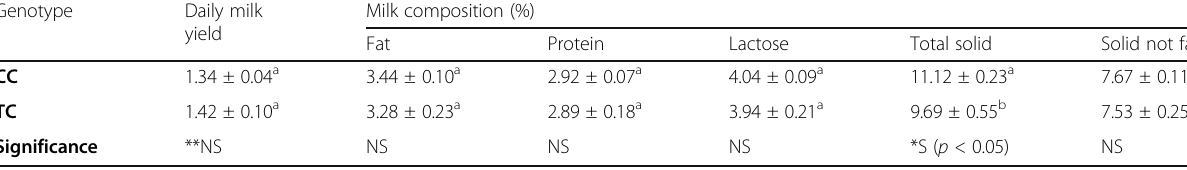
Table 2 LSM (± SE) of daily milk yield and composition in Zaraibi goats as affected by DGAT1 genotypes